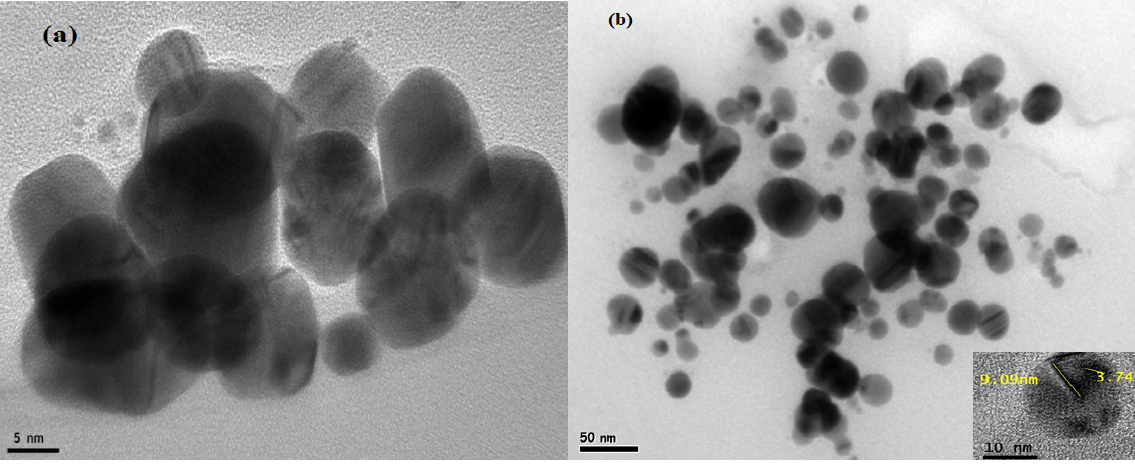
Figure 2. TEM micrographs of ( a ) Ag NPs and ( b ) silver AMPS/NIPAm hybrid polymer.